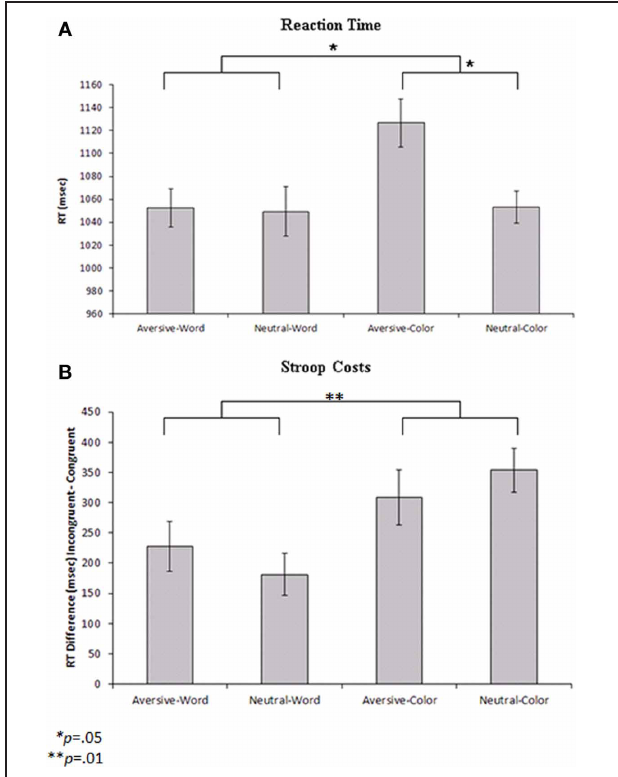
FIGURE 2 | (A) Reaction times to the probe stimuli for each condition with repeated-measures error bars. Color cues led to significantly slower reaction times than word cues ( p = 0 . 05), and aversive trials led to slower reaction times than neutral trials within the color condition ( p = 0 . 05). (B) Reaction time differences between incongruent and congruent probe stimuli (Stroop costs) for each condition with repeated-measures error bars. Color cues led to significantly greater Stroop costs than word cues ( p = 0 .